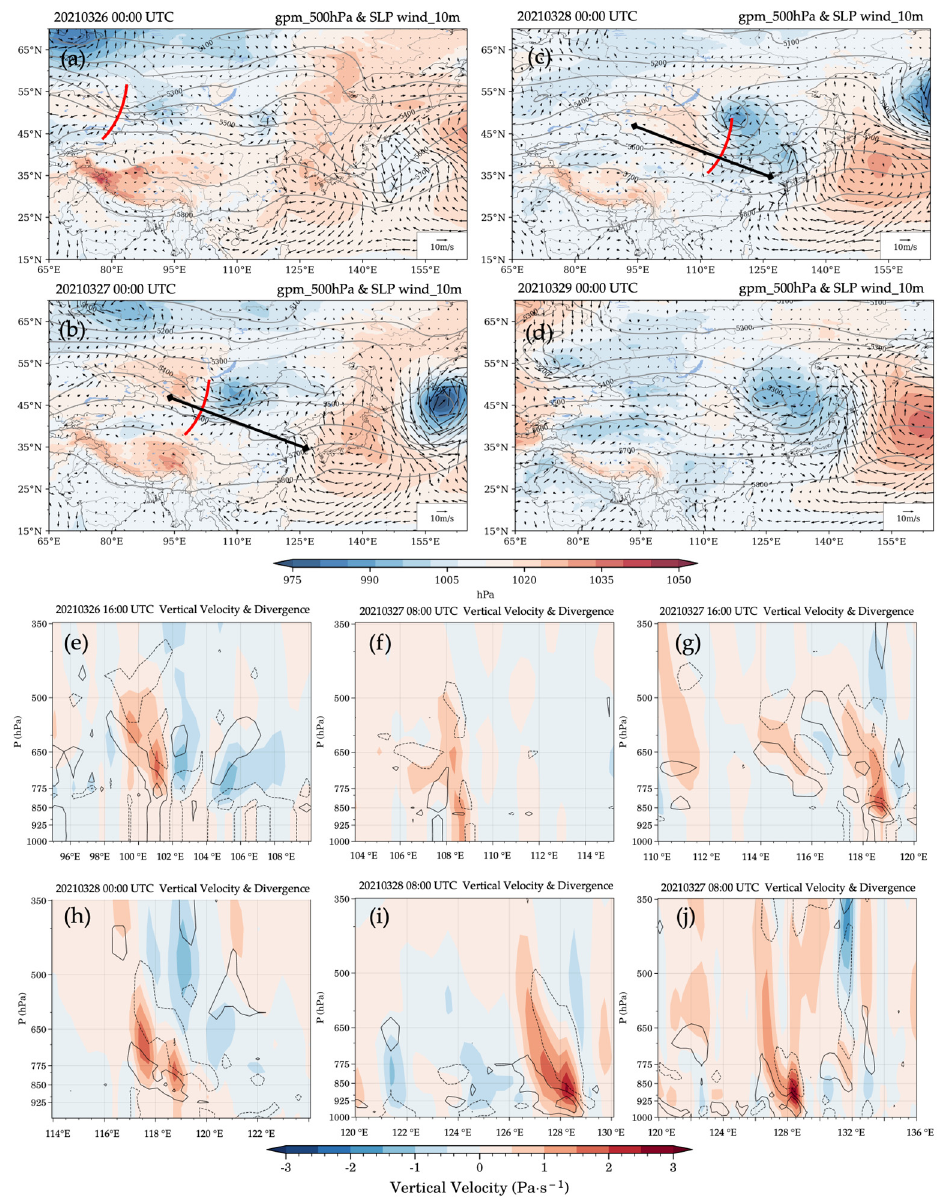
Figure 8. ( a – d ) The sea level pressure (shading) overlapped by 500 hPa geopotential height contours (gray contours) and 10-m horizontal wind vectors (arrow). ( e – j ) The cross-sections of vertical velocity (shading) and the divergence (black contours) along the dust path (dark line in panel ( b )) for the 3·28 event.